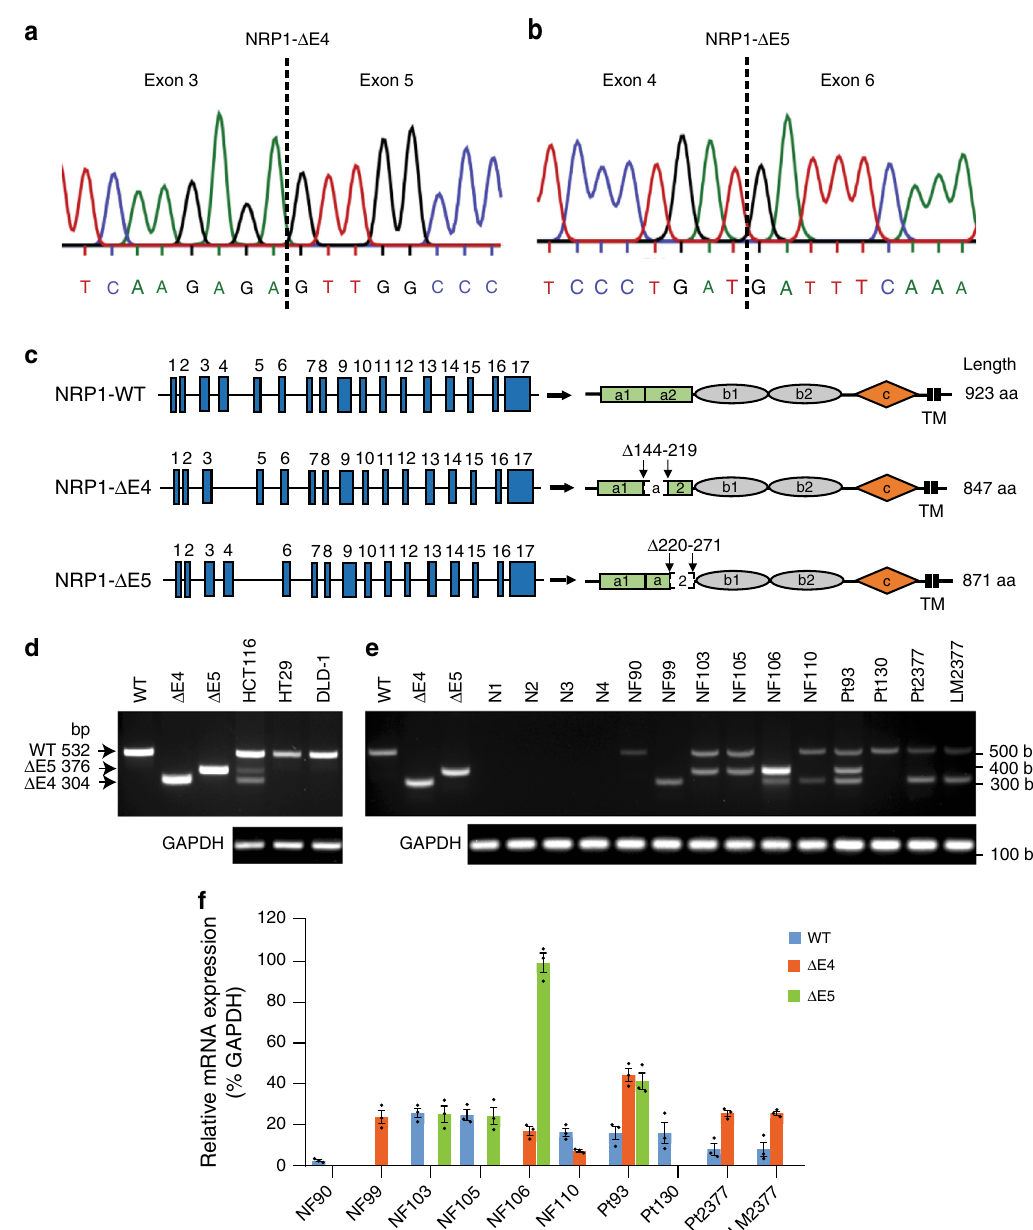
Fig. 1 NRP1- Δ E4 and NRP1- Δ E5 are commonly expressed in CRC. a , b Sequencing analysis of several human NRP1 cDNA clones identi fi ed two NRP1 splice variants: a splicing of exon 3 to exon 5 a and a splicing of exon 4 to exon 6 b . c Schematics of genomic (left) and protein (right) structures of the NRP1 gene and the full-length WT NRP1 as well as two identi fi ed splice variants, NRP1- Δ E4 and NRP1- Δ E5. d , e RT-PCR analysis was performed on total RNA isolated from CRC cell lines d , and normal (N1-4) and CRC tissues, as well as primary CRC cell lines e . The high, middle and low molecular weight products of 532 bp, 376 bp and 304 bp are ampli fi ed from NRP1-WT, NRP1- Δ E5 and NRP1- Δ E4, respectively. GAPDH ampli fi cation was used as control for RT-PCR. f The expression levels of NRP1-WT, NRP1- Δ E4 and NRP1- Δ E5 relative to GAPDH expression levels in CRC tissues as shown in e are quanti fi ed using Image J software. The data are presented as mean ± s.e.m. ( n = 3 independent